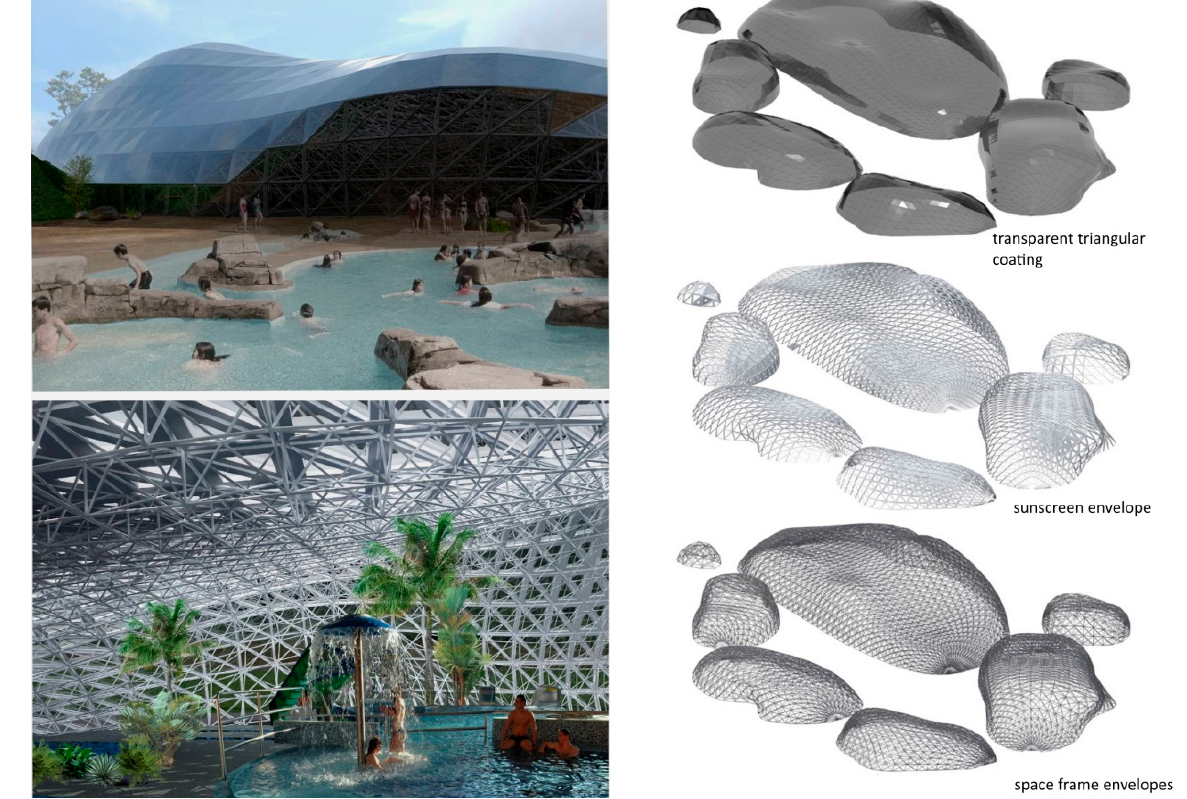
Figure 3. Wind deflation and recreation, modelling space frame structure of envelopes (Micha ł Czapiewski).